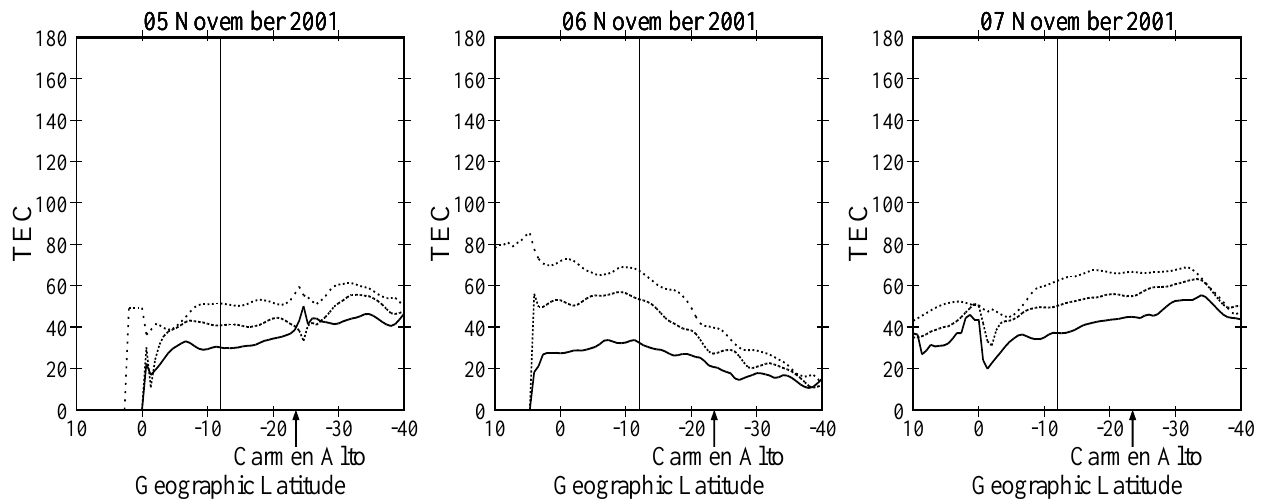
Fig. 10. Total electron content (x10 6 electronscm − 2 ) along American longitude sector, derived from the GPS phase fluctuations for 5–7 November 2001, at 06:00 LT (solid line), 07:00 LT (middle line) and 08:00 LT (dotted line). During this time period, enhancements were observed in the dayglow emissions on 6 November (see Fig. 7). Magnetic equator is shown as a vertical line. Carmen Alto is located at approximately 23.16 ◦ geographic latitude as indicated by an arrow. It can be seen that the TEC on 6 November did not show any increase corresponding to the increase in dayglow emissions. Actually, a factor of 1.5–2 smaller TEC was measured on this day compared with the quiet day, thus indicating no role of electron densities in the observed dayglow emission enhancement. Hence, it is suggested that a possible increase in the neutral densities be responsible for the rise in the observed dayglow emissions on this day. Also, the asymmetric nature of the TEC distribution with respect to latitude on 6 November indicates the presence of strong equatorward winds that bring neutrals from the high